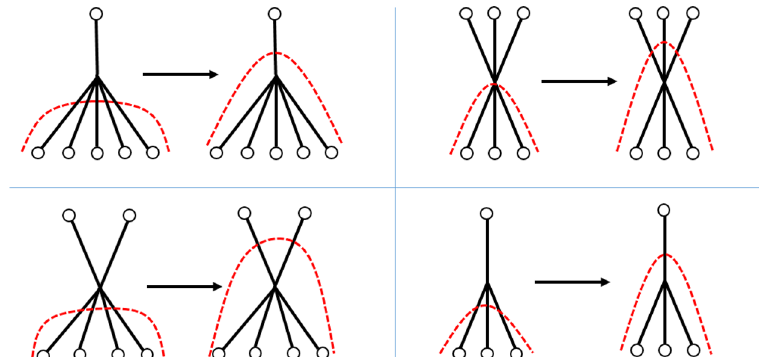
Figure 23. We start with an initial surface and update the curve γ A (red dashed curve) via these moves until the algorithm terminates at a local